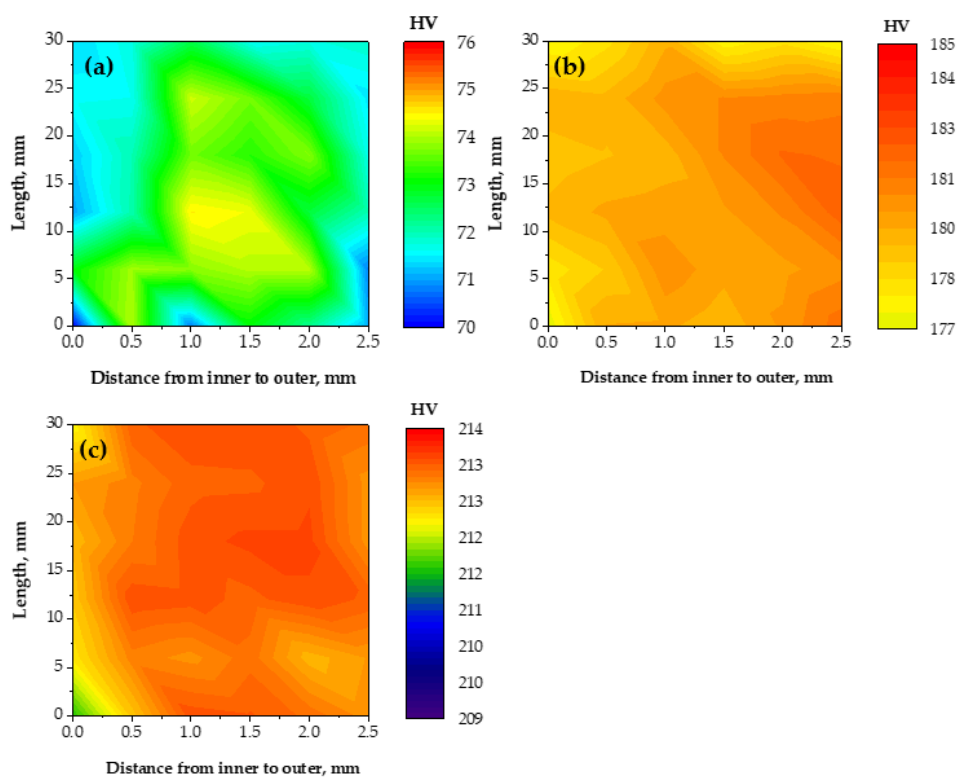
Figure 8. Hardness distribution map of the brass tube alloy along the tube thickness cross-section, with the distance from the inner to the outer surface: ( a ) annealed, ( b ) after the first pass, and ( c ) after the second pass of the PTCAP processing.